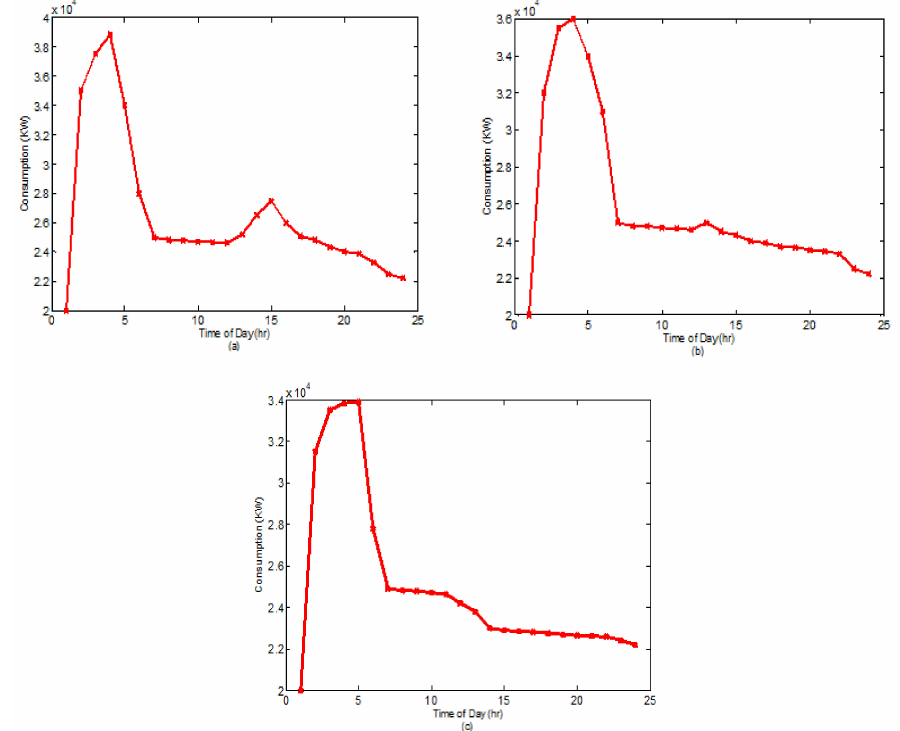
Figure 2. Net energy consumption of 2500 households for ( a ) No implementation of DR program; ( b ) Last optimization iteration using a DR program and utilization of renewable energy sources (RES) by the DSO; and ( c ) Last optimization iteration using a DR program and utilization of RES by the end